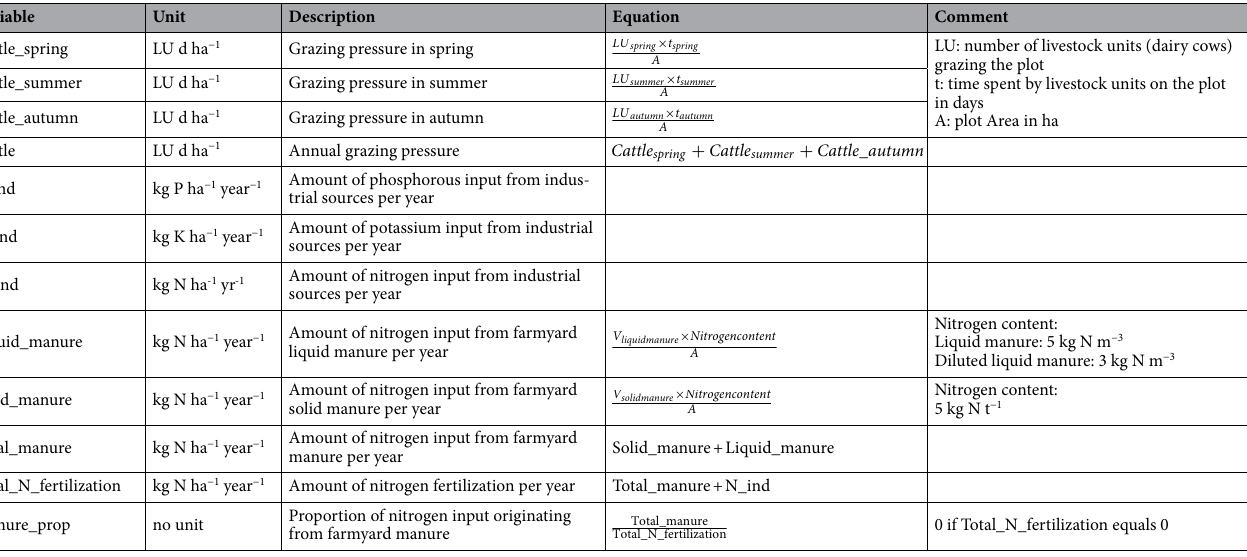
Table 4. Method description for calculating agricultural